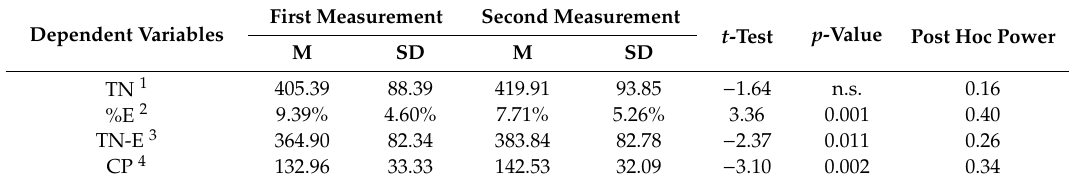
Table 1. The results of selective attention (D2) before and after 12 weeks of the Nordic Walking training program. Dependent Variables